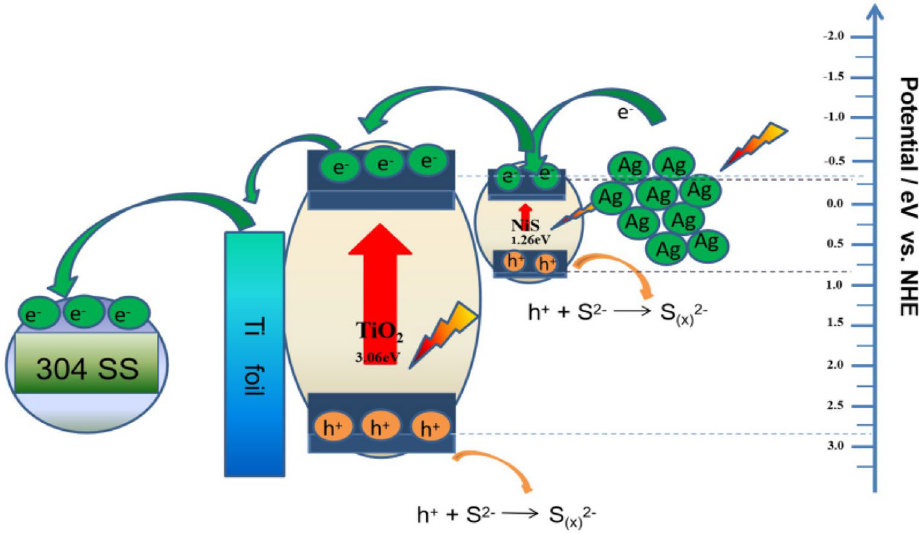
Figure 11. Schematic diagram of the photoelectrochemical anticorrosion process in the Ag/NiS/TiO 2 nanocomposites under visible